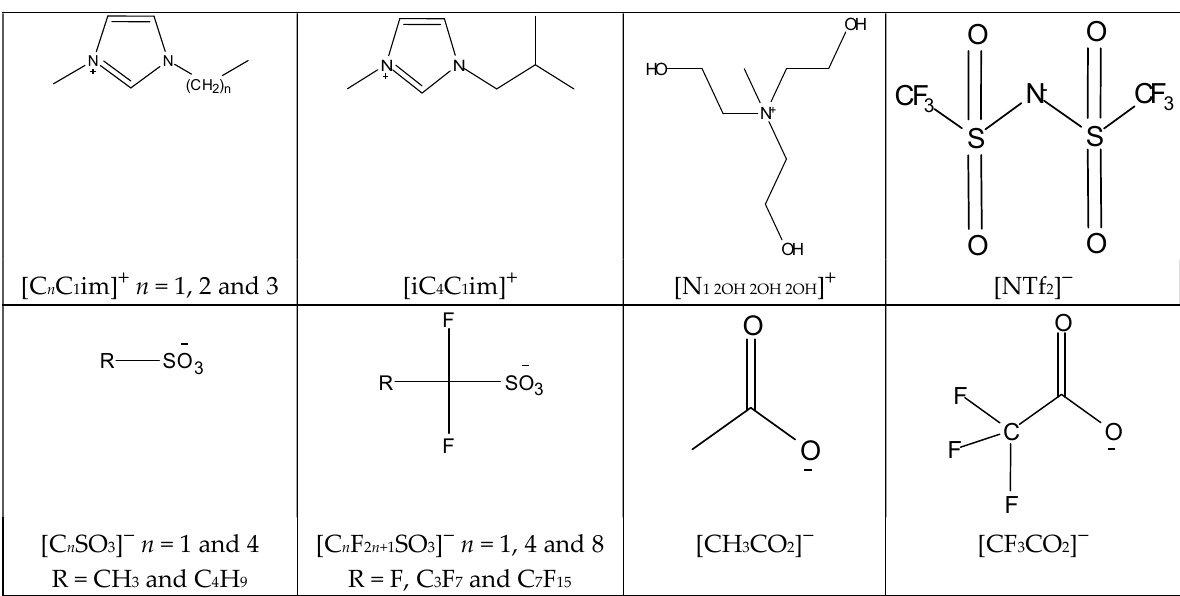
Table 1. Details of the molecular dynamics simulations performed for the water–ionic liquid mixtures and the corresponding sections where the systems are discussed. The final box length at 300 or 320 K is represented by l box (in nm); the number of IL pairs and water molecules are, respectively, n IL and n water ; the IL weight fraction is represented by wt IL ; and the IL mole fraction is denoted as X IL .